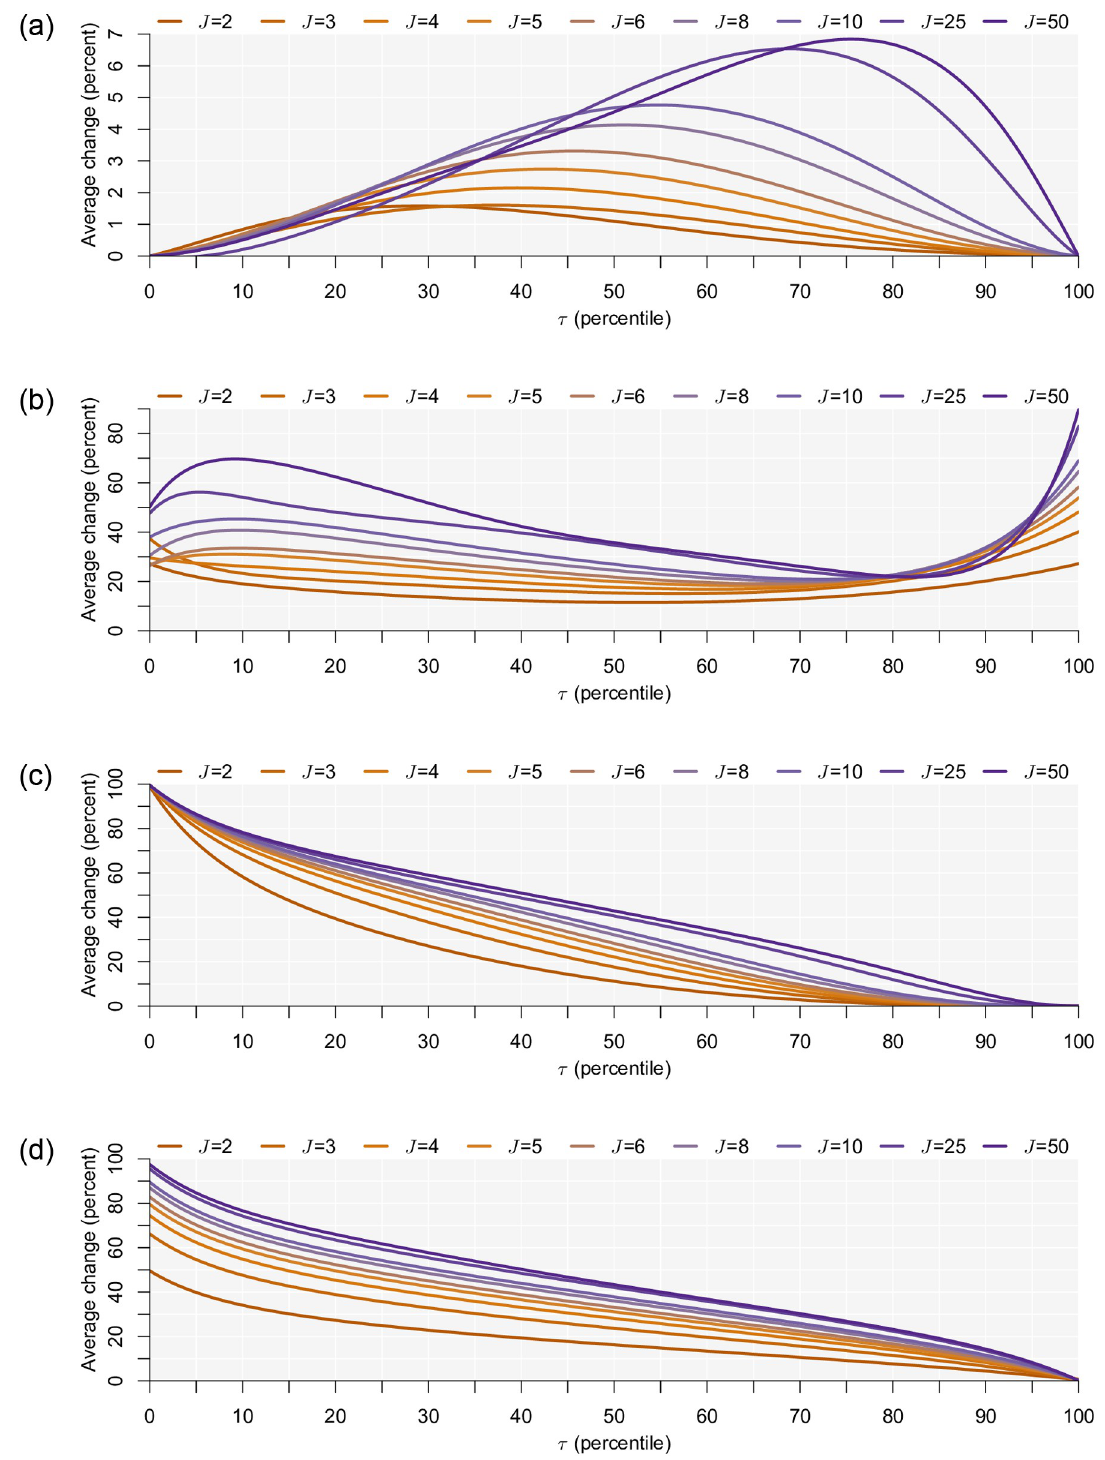
Fig 2. Change in choices correctly predicted under satisficing model relative to the na ï ve baseline model. (a) Data generated on basis of choose the utility maximizing alternative secondary decision rule. (b) Data generated on basis of choose the opt-out alternative secondary decision rule. (c) Data generated on basis of choose the last alternative secondary decision rule. (d) Data generated on basis of choose a random alternative secondary decision rule.